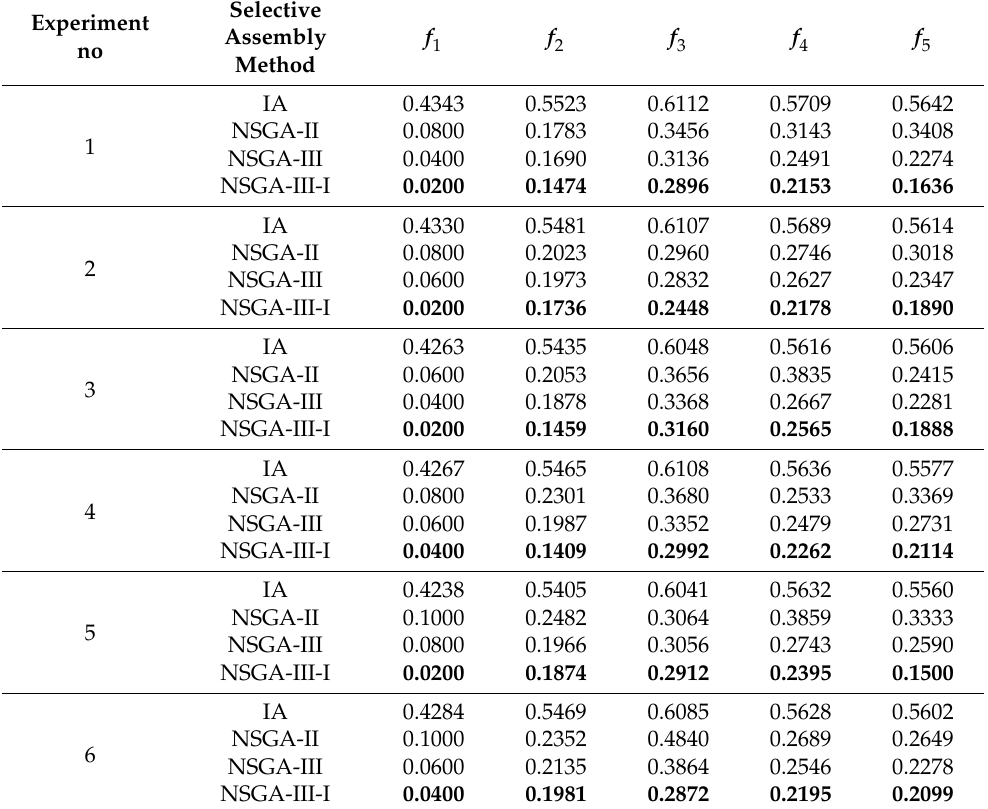
Table A2. The dominant relation of the partial solution of each algorithm.